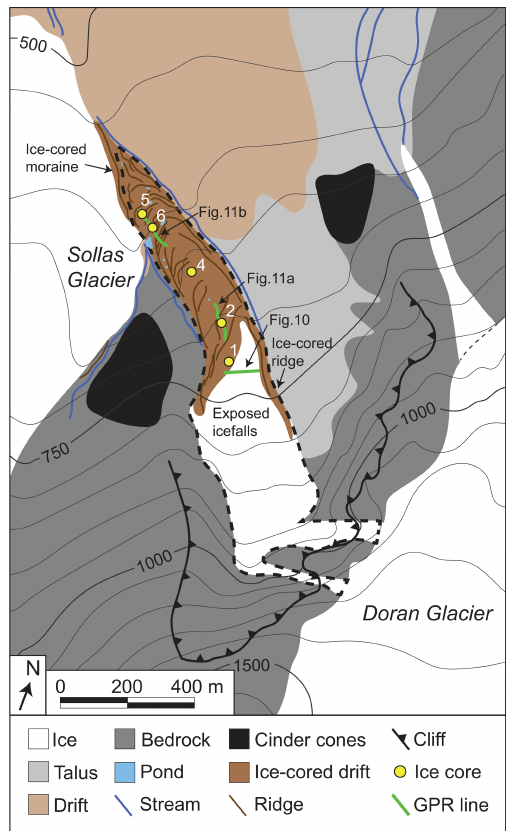
Figure 2. Geomorphic map of the modern rock glacier (outlined in the large black dashed line) and surrounding terrain. Contour in- terval: 50m. Ice cores SLI-15-01, SLI-15-04, and SLI-15-05 are from buried ice (labeled 1, 4, and 5). SLI-15-02 and SLI-15-03, and SLI-15-06 and SLI-15-07 are duplicate cores taken from two large frozen ponds (only 2 and 6 labeled). Ground-penetrating radar (GPR) lines are shown in green; one line transverse to rock glacier flow (Fig. 10) and two lines longitudinal to flow (Fig. 11).